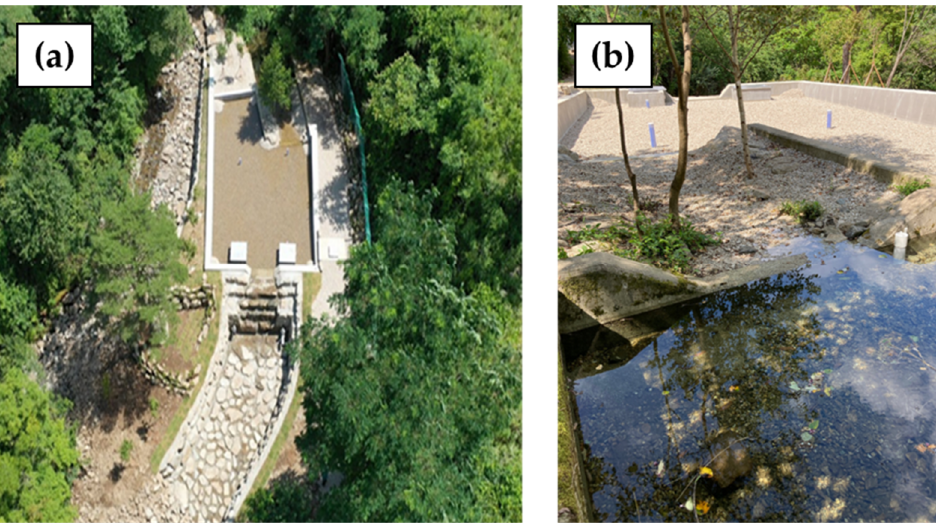
Figure 5. Plan view of the sand dam ( a ) and detail showing the connection between the old reservoir (pond) and the sand dam ( b ).